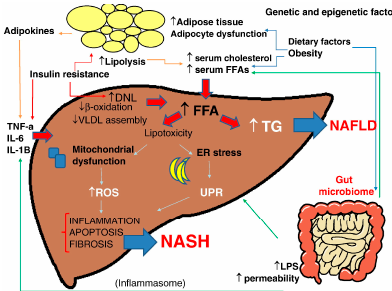
Figure 2. Multiple parallel-hit hypothesis of nonalcoholic fatty liver disease (NAFLD). Obesity together with dietary habits and environmental factors can lead to raised serum levels of free fatty acids (FFAs) and cholesterol, development of insulin resistance, adipocyte proliferation, and dysfunction in the intestinal microbiome. Insulin resistance acts on adipose tissue, worsening adipocyte dysfunction, induces hepatic de novo lipogenesis (DNL) and release of proinflammatory adipokines such as interleukin (IL)-6, IL-1 β , and tumor necrosis factor (TNF)- α , which also exacerbates the insulin resistance state. The increased hepatic FFAs flux which derives from the above processes and from an altered activity of the gut microbiome leads to accumulation of triglycerides (TGs) and “toxic”levels of FFAs, free cholesterol, and other lipid metabolites which cause mitochondrial dysfunction, oxidative stress with the production of reactive oxygen species (ROS), and endoplasmic reticulum (ER) stress with the activation of the unfolded protein response (UPR), all leading to hepatic inflammation and fibrogenesis (nonalcoholic steatohepatitis, NASH). Increased intestinal permeability of gut-derived microbial products such as lipopolysaccharides (LPS) contributes to the activation of the inflammasome, ER stress, and activation of inflammatory cascades. Epigenetic factors are also involved in progression to NASH or persistence in a stable stage of disease (with permission from [34]). VLDL: very low density